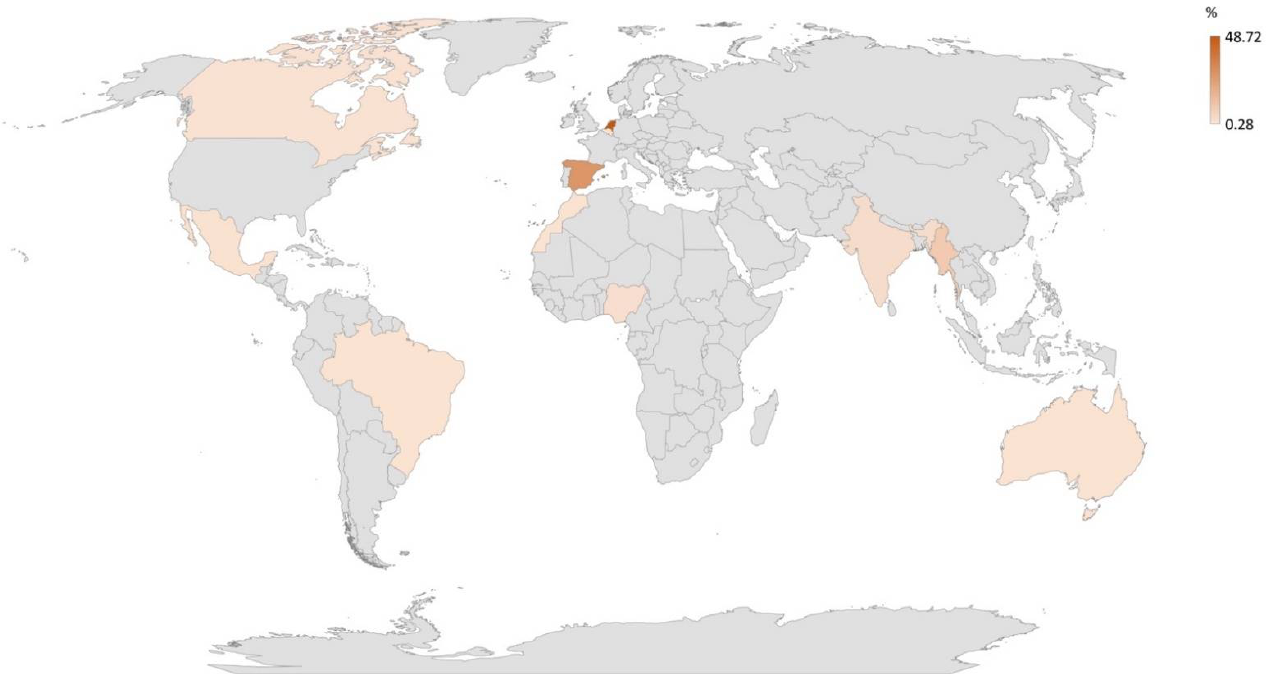
Figure 1. Spatial plot of all countries represented in current multinational study: the Netherlands (48.7%, n = 171), Spain (27.6%, n = 97), Myanmar (9.7%, n = 34), India (3.1%, n = 11), Nigeria (2.6%, n = 9), Mexico (1.7%, n = 6), Morocco (1.4%, n = 5), Australia (1.1%, n = 4), Brazil (1.1%, n = 4), Belgium (0.9%, n = 3), Canada (0.9%, n = 3), Curaçao (0.3%, n = 1), Guatemala (0.3%, n = 1), Panama (0.3%, n = 1), and Singapore (0.3%, n = 1).